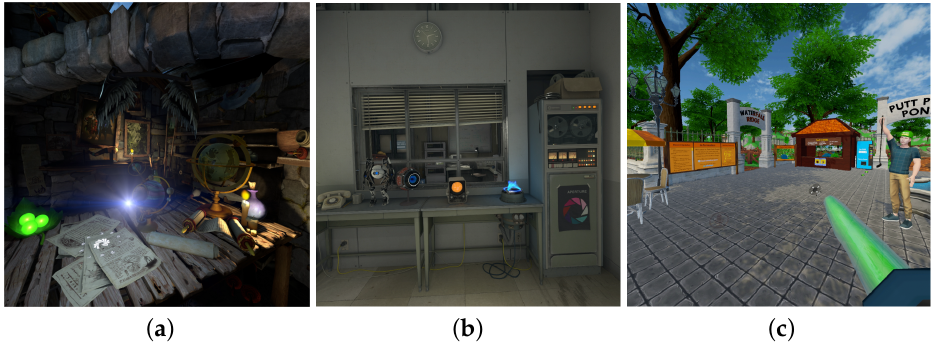
Figure 5. Examples of the test set. ( a ) Secret Shop. ( b ) Robot Repair. ( c )